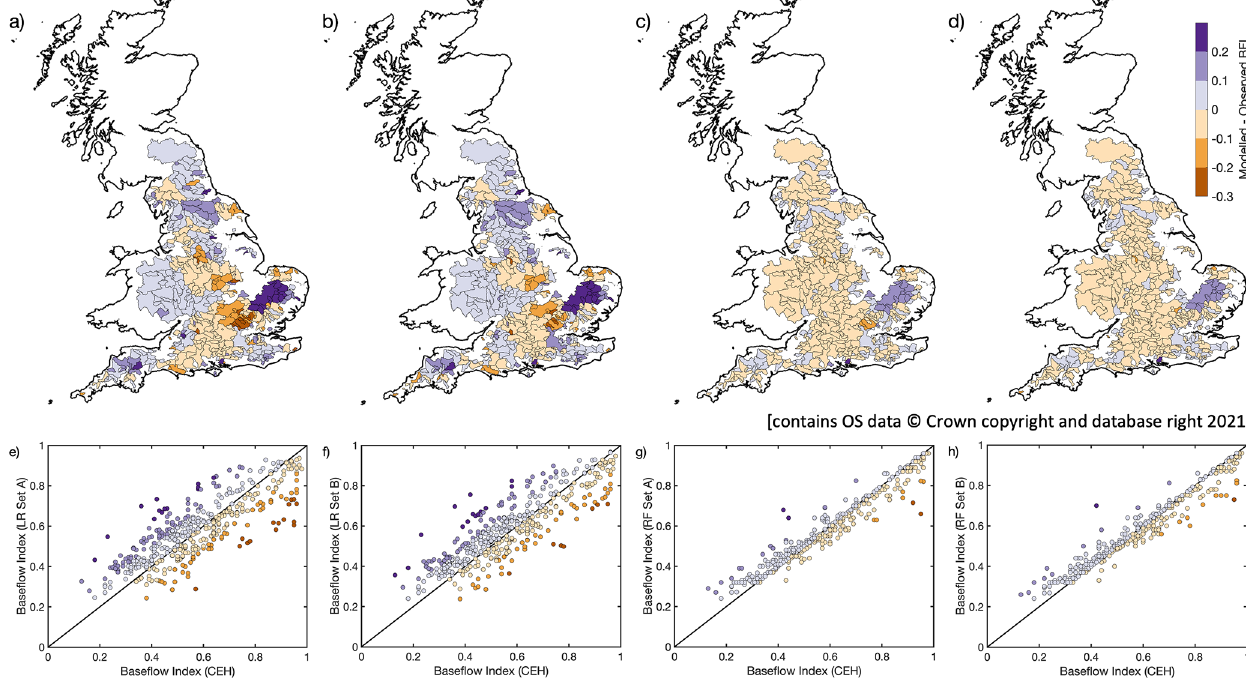
Figure A2. Maps of difference between modelled and observed BFI_CEH (a–d) and corresponding scatter plots of BFI_CEH against modelled BFI (e–h) for covariate Sets A and B for LR and RF models (Models 2, 4, 6, and 8). (Note this is the same as Fig. 6 but for BFI_CEH.)